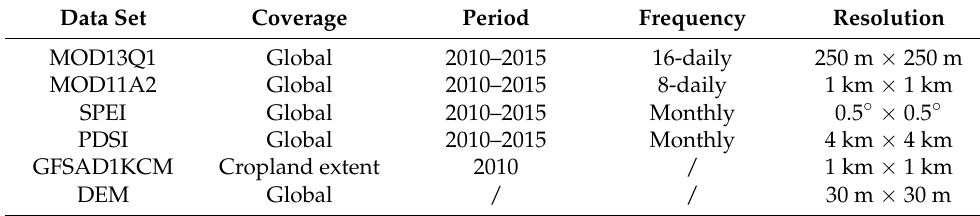
Table 1. Details of the remote sensing datasets and auxiliary datasets. Data Set